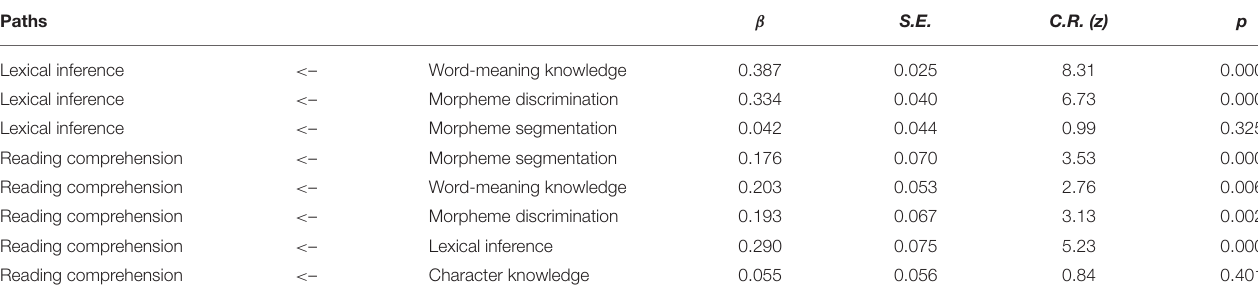
TABLE 3 | Standardized regression weights for a preferred path model.